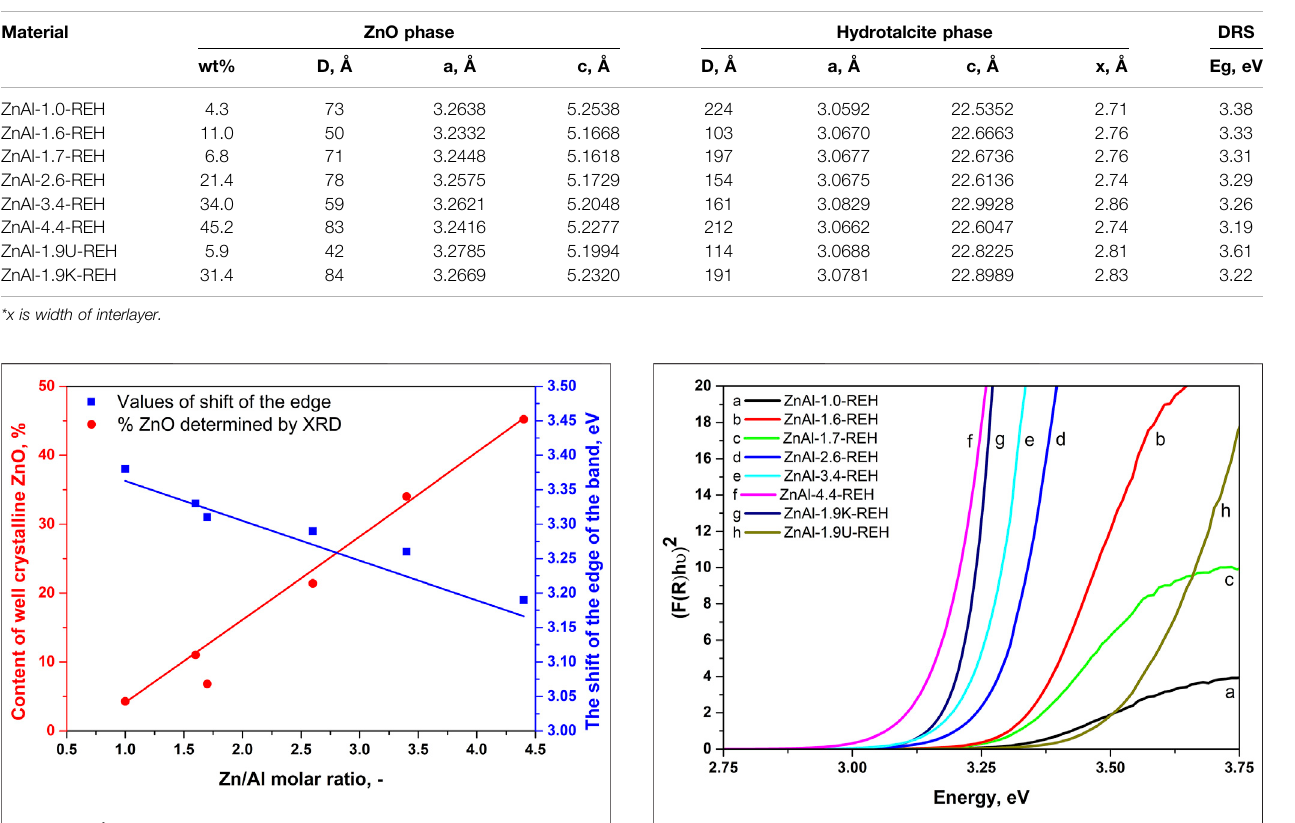
FIGURE 2 | Dependences of the content of well crystalline ZnO phase determined by XRD (red marks, left side) and the shift of the edge of the band (blue marks, right side) on Zn/Al molar ration of ZnAl-X-REH reconstructed materials.